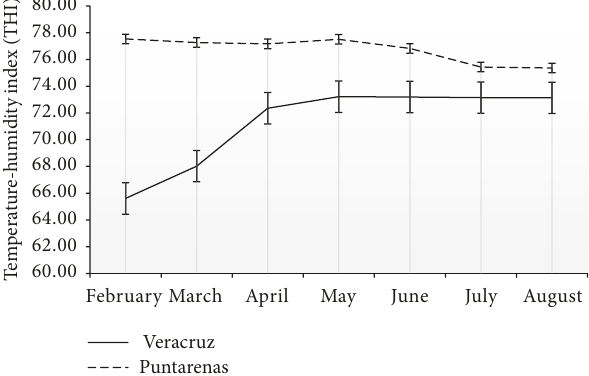
Figure 1: Temperature-humidity index (THI) for Veracruz and Puntarenas from the months of February to August